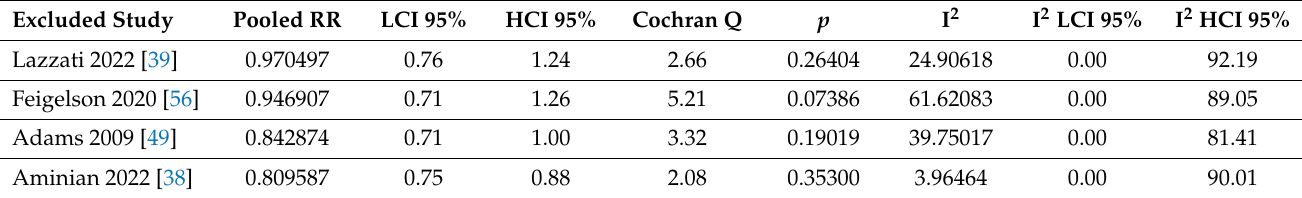
Figure A6. Postmenopausal breast cancer random e ff ects model funnel plot.